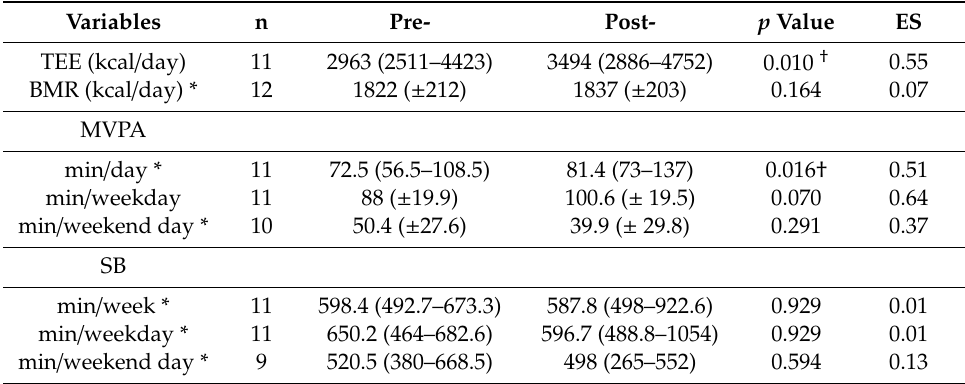
Table 5. Energy expenditure, physical activity, and sedentary behavior before and during the intervention